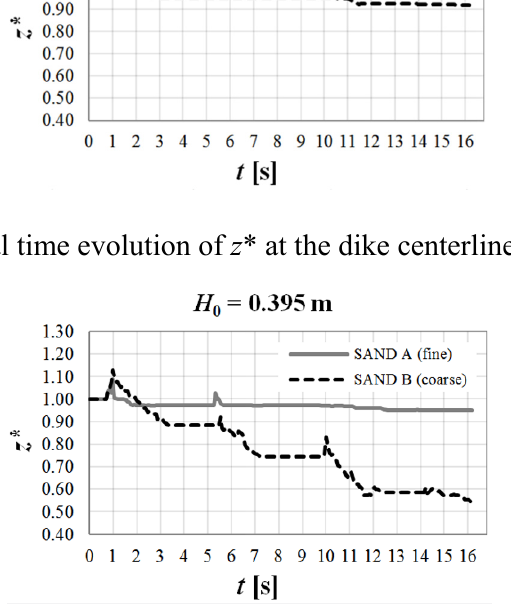
Figure 4. Experimental time evolution of z * at the dike centerline for Tests A3 and B3.